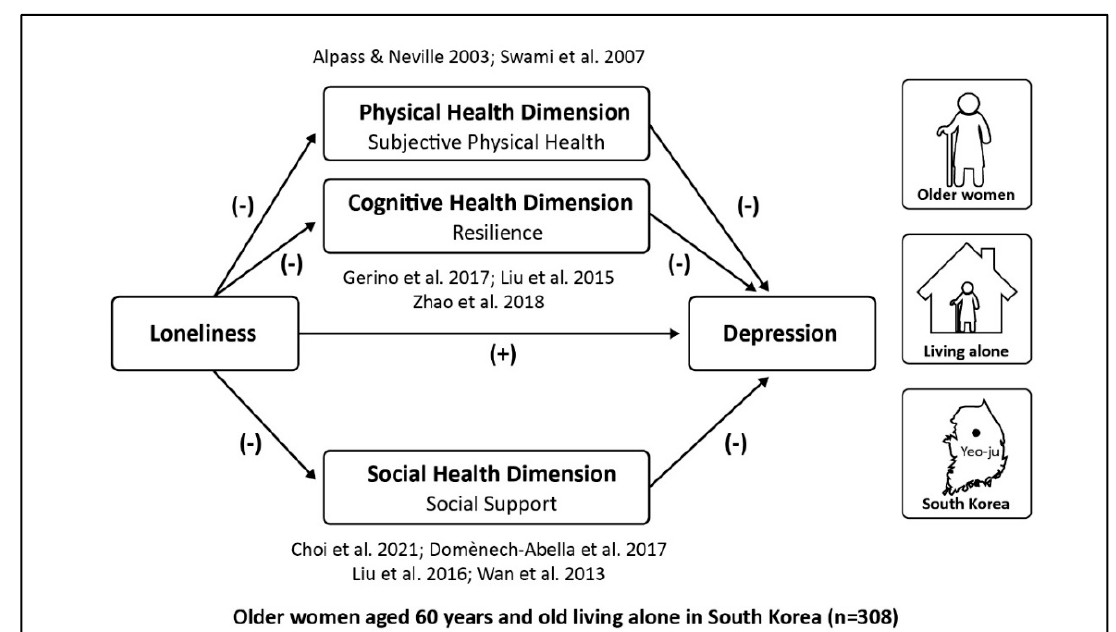
Figure 1. Conceptual model [11,12,21,22,24,26,27,30].